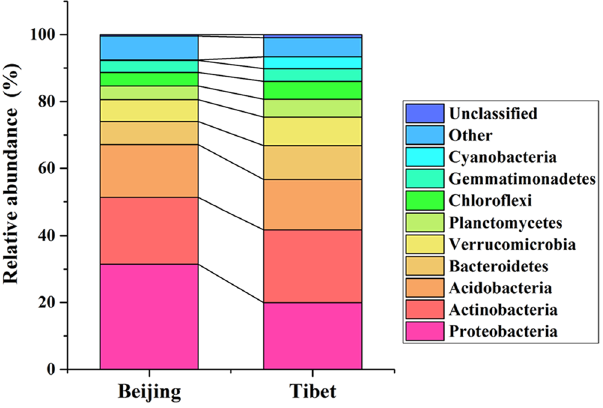
Figure 1. Relative abundances of nine dominant phyla in two sampling sites.